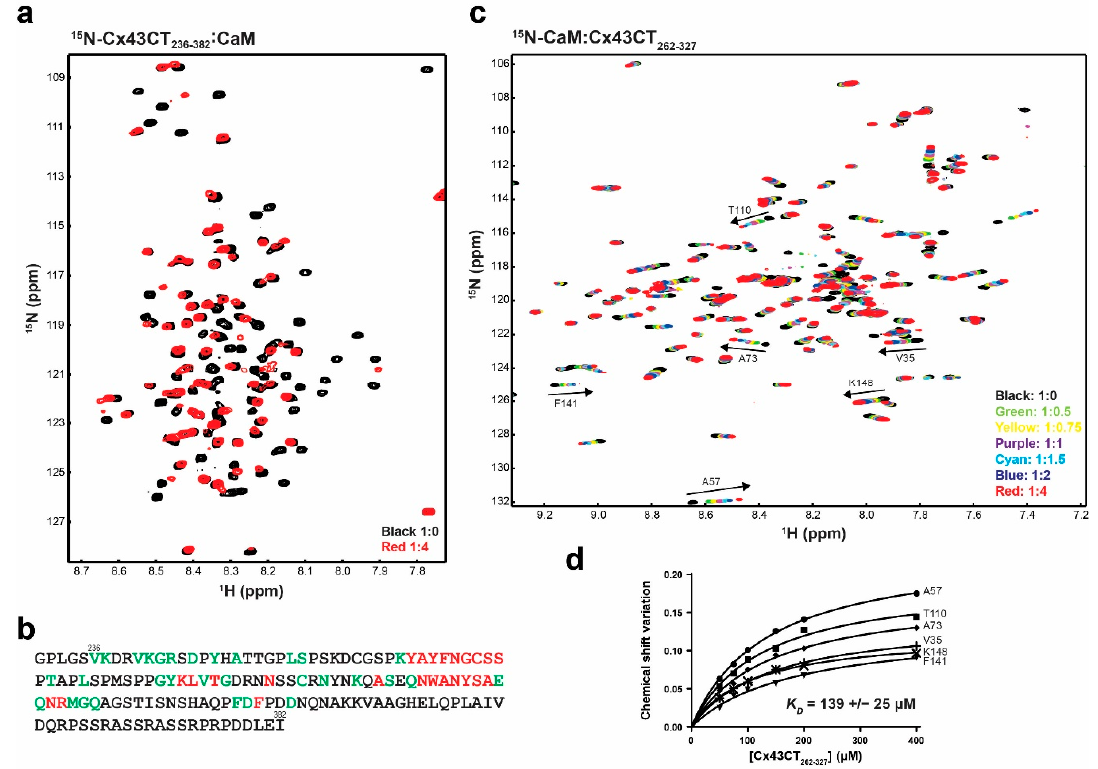
Figure 7. Characterizing the interaction between the Cx43CT 236-382 domain and CaM. ( a ) 15 N-HSQC spectrum of 15 N-labeled Cx43CT 236-382 alone (black) has been overlaid with the spectrum collected in the presence of unlabeled CaM in 10 mM CaCl 2 (red, molar ratios indicated in the lower right corner). ( b ) Summary of the Cx43CT residues affected by the interaction with CaM when CaCl 2 is present (green, peaks shift; red, peaks broaden beyond detection). ( c ) 15 N-HSQC spectrum of 15 N-labeled CaM alone (black) has been overlaid with spectra collected in the presence of increasing molar ratios of unlabeled Cx43CT 262-327 (ratios indicated in the lower right corner). The residues used to calculate the dissociation constant (K D , panel d ) have been labeled. ( d ) Fitting of the binding isotherms. Overall K D and standard deviation were calculated by averaging the individual K D obtained for each residue.